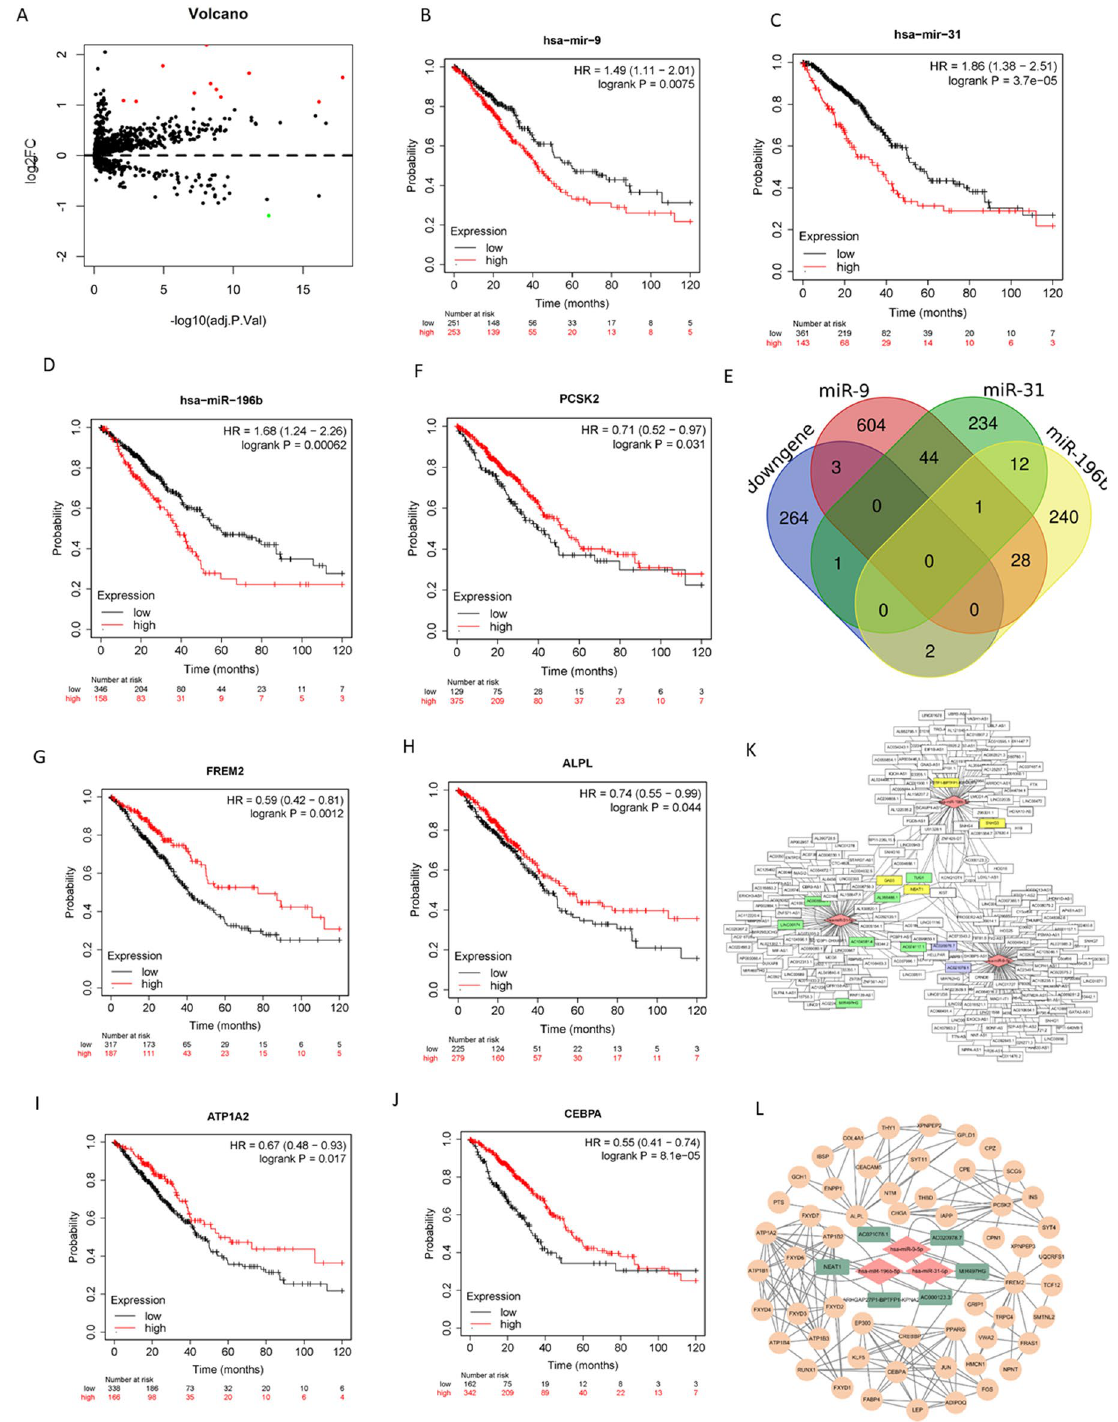
Figure 6. Identification prognosis-related differentially expressed microRNAs and conduction of the ceRNA regulation network under hypoxic status. ( A ) Volcano plot for differentially expressed microRNAs in cluster1 and cluster2. Red and green dots represent up-regulated and down-regulated in cluster1 relative to cluster2, respectively (P < 0.01, |logFC|> 1). ( B – D ) The overall survival curves of hsa-miR-196b, hsa-miR-31, hsa-miR-9 in TCGA-LUAD. ( E ) Venn diagrams showing the intersection between predicted target genes of hsa-miR-196b/ hsa-miR-31/hsa-miR-9 and DEGs. ( F – L ) The overall survival curves of PCSK2, FREM2, ALPL, ATP1A2, CEBPA in TCGA-LUAD. ( K ) The microRNA-lncRNA networks of the target lncRNAs of hsa-miR-196b, hsa-miR-31 and hsa-miR-9. ( L ) The ceRNA regulation network based on differentially expressed microRNAs and DEGs under hypoxic